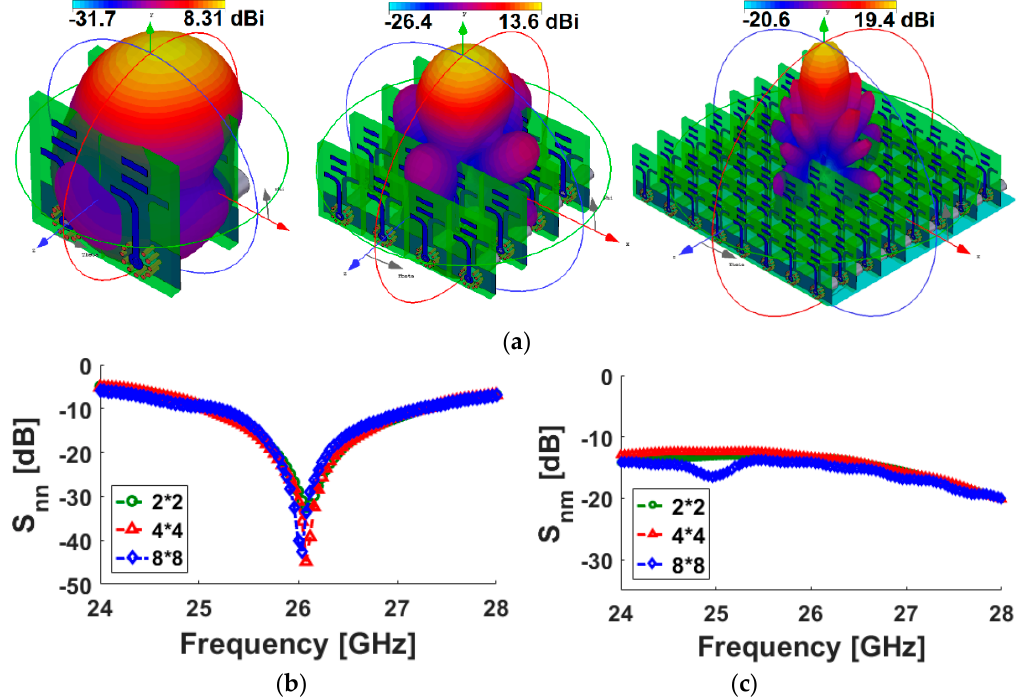
Figure 20. ( a ) Radiation beams, ( b ) S nn , and ( c ) S nm characteristics of the planar arrays.